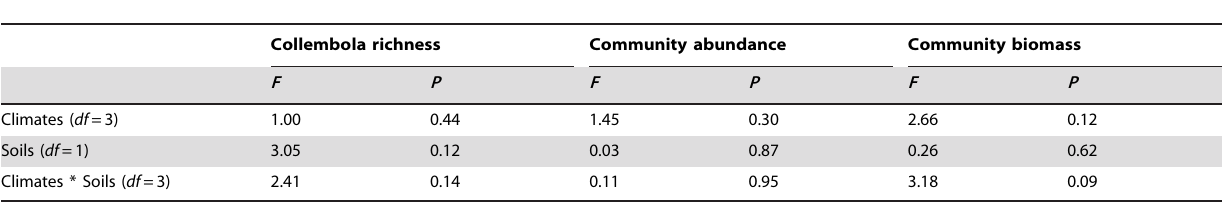
Table 3. Effects of climate treatments and soil types on Collembola and